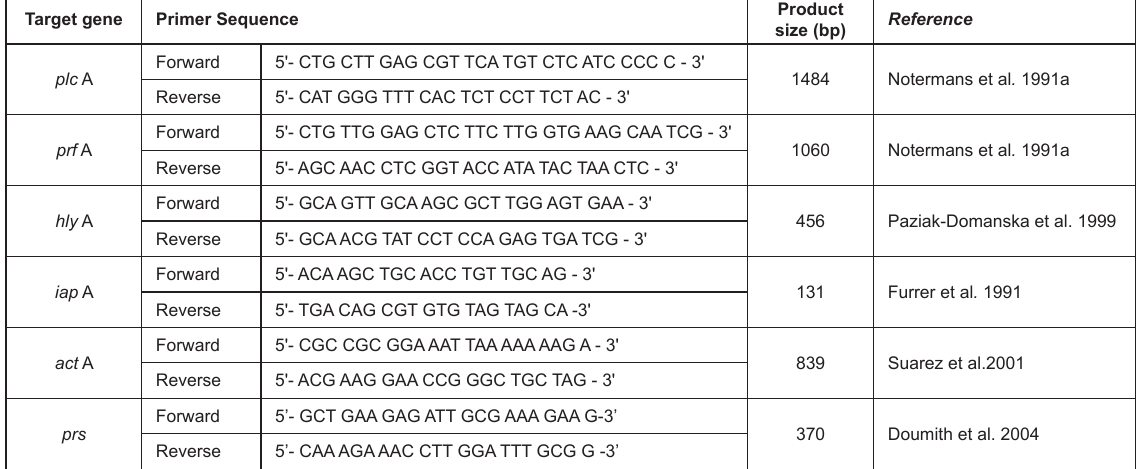
Table 1. Details of primers for amplification of virulence marker associated genes of L. monocytogenes Target